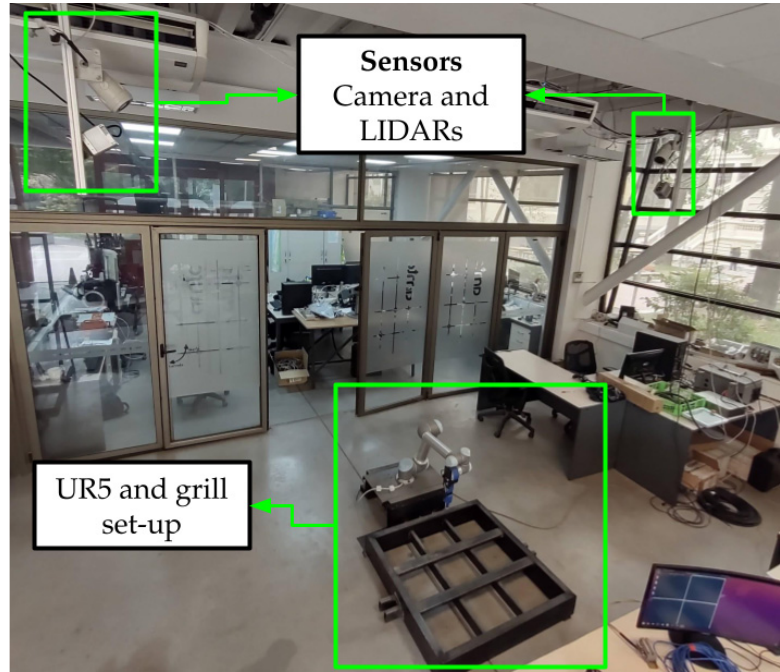
Figure 16. Experimental set-up.